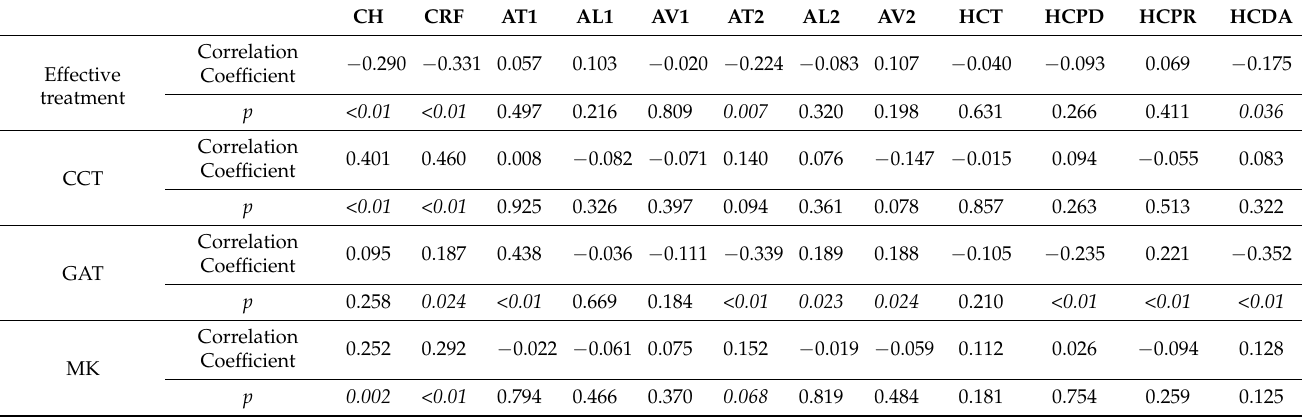
Table 3. Correlations between corneal biomechanical properties (CBP) parameters and other features at 6 months follow-up.